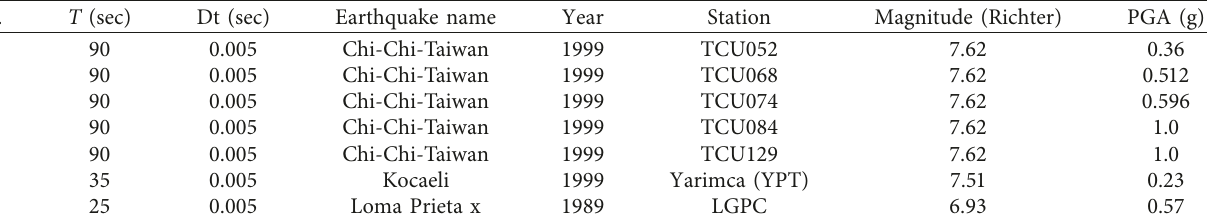
Table 8: Characteristics of selected records.